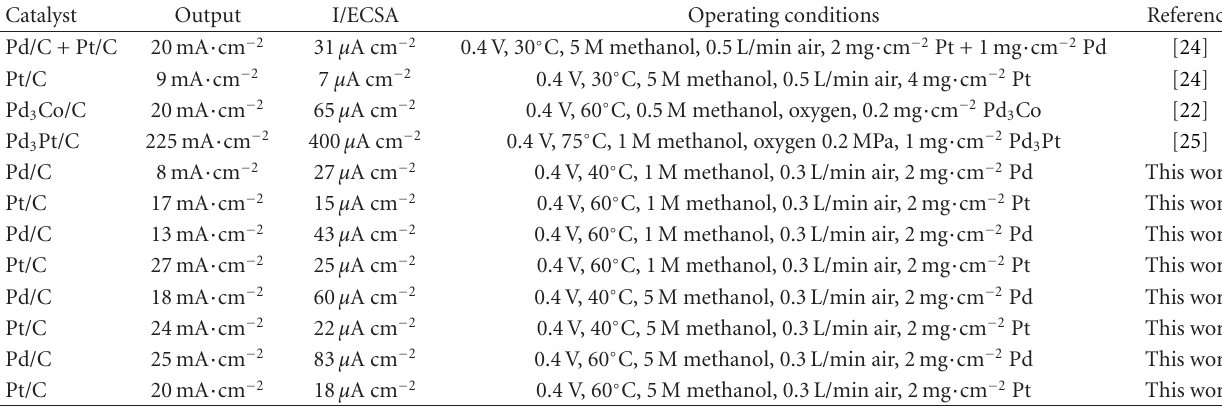
Table 6: Comparison of Pd catalysts performance with published